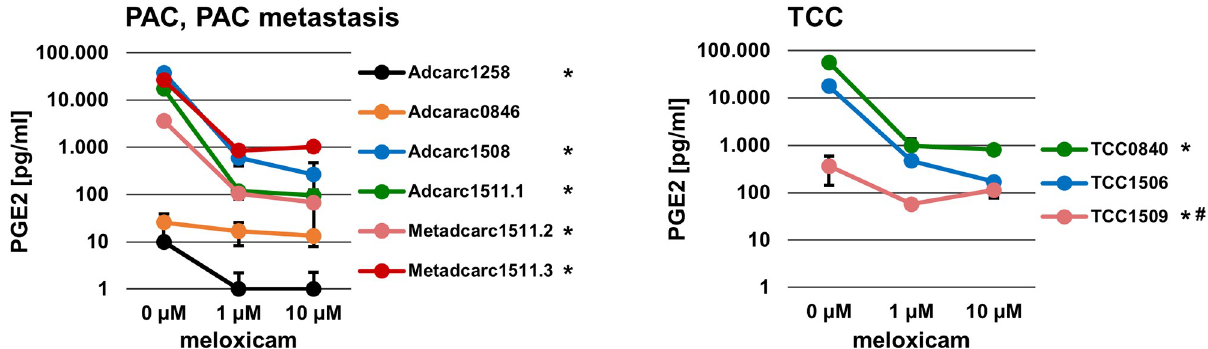
Fig 9. PGE2 production of cell lines after 24 h incubation with meloxicam. Measured in duplicates by competitive ELISA; � PGE2 production in pg/ ml medium in both meloxicam concentrations, compared to 0 μ M DMSO control (Dunnett’s test for multiple comparisons), # additional significant difference between 1 and 10 μ M in cell line TCC1509 (Student’s t-test), p <